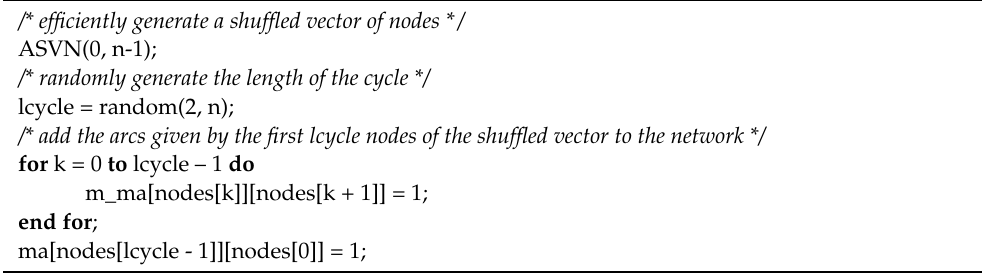
Algorithm 6. Algorithm Random Directed Elementary Cycle v2 (ARDEC2)